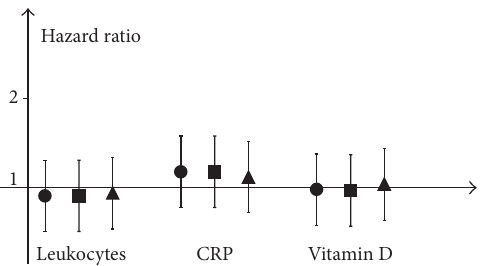
Figure 2: Hazard ratios for leukocytes, CRP, and vitamin